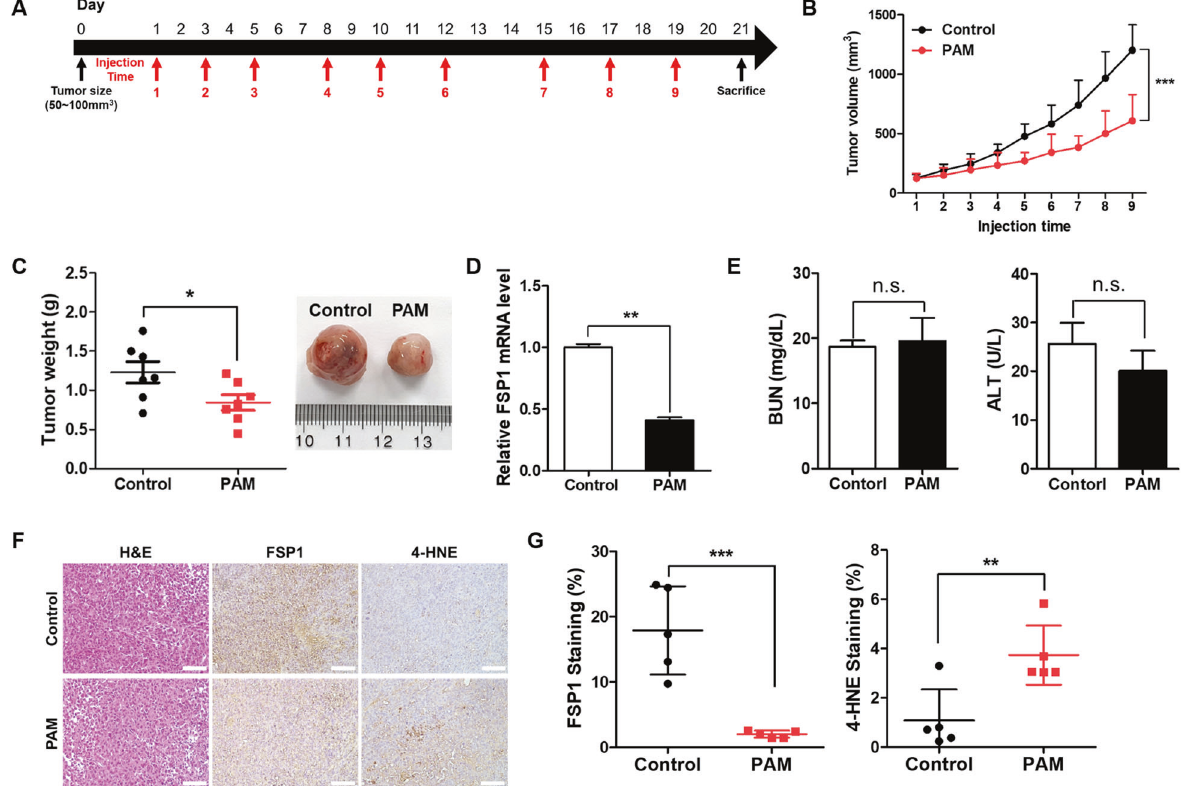
Fig. 5 Plasma-activated medium suppresses tumor growth by regulating ferroptosis. The plasma exposure conditions were 1.9 standard liter per minute (SLM), 7 W input power and 180 sec. A Mouse treatment schedule. B Tumor volumes were determined at injection time points before PAM treatment. Data represent the mean ± SD from seven independent experiments (*** p < 0.001, as determined by t test). C Tumor weights were measured after the tumors were dissected. Data represent the mean ± SD from seven independent experiments (* p < 0.01, as determined by t test). D The mRNA levels of FSP1 were measured by qRT-PCR. Data represent the mean ± SD from three independent experiments (* p < 0.05, ** p < 0.01 and *** p < 0.001, as determined by t test). E BUN and ALT were analyzed and compared between the control and PAM treatment groups. Data represent the mean ± SD from fi ve independent experiments (n.s.; not signi fi cant, as determined by t test). F Tumor tissue sections were stained with hematoxylin-eosin (H&E) and immunohistochemical staining (FSP1 and 4-HNE). Representative images of stained tumor tissue. Scale bar = 100 μ m. G Immunochemistry scoring of FSP1 and 4-HNE staining. Data represent the mean ± SD from fi ve independent experiments (** p < 0.01 and *** p < 0.001, as determined by t